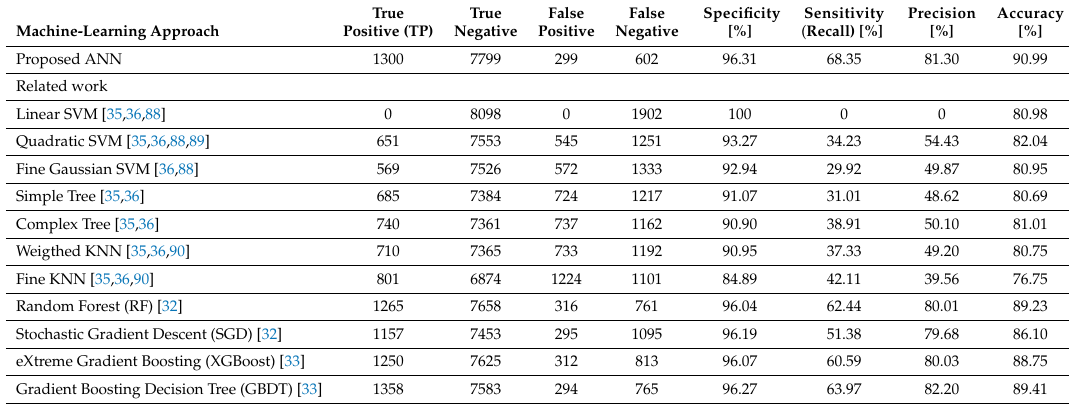
Table 10. Comparison of the proposed ANN model versus other M-L approaches.